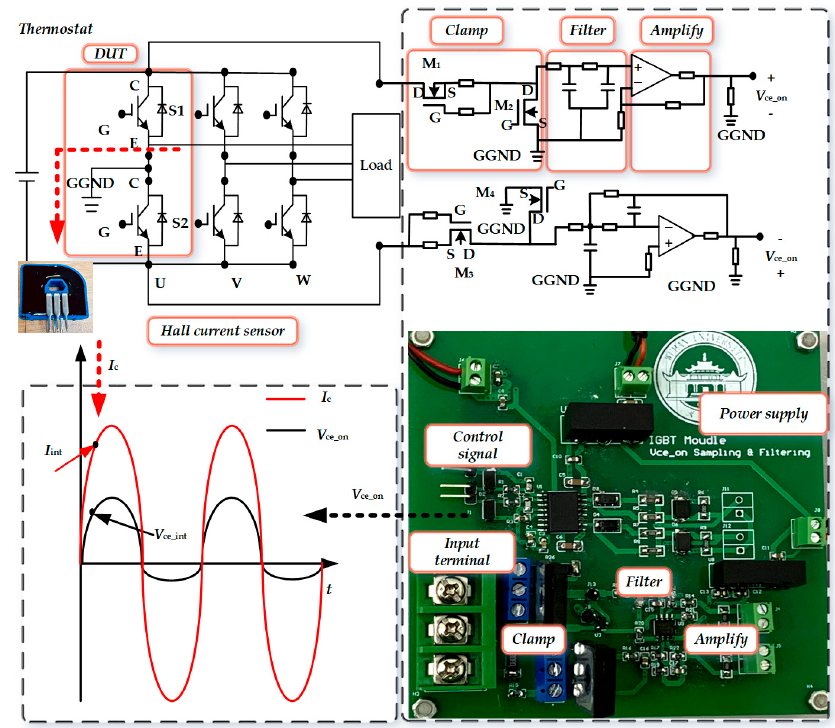
Figure 3. Working principle of the voltage and current sampling circuit.